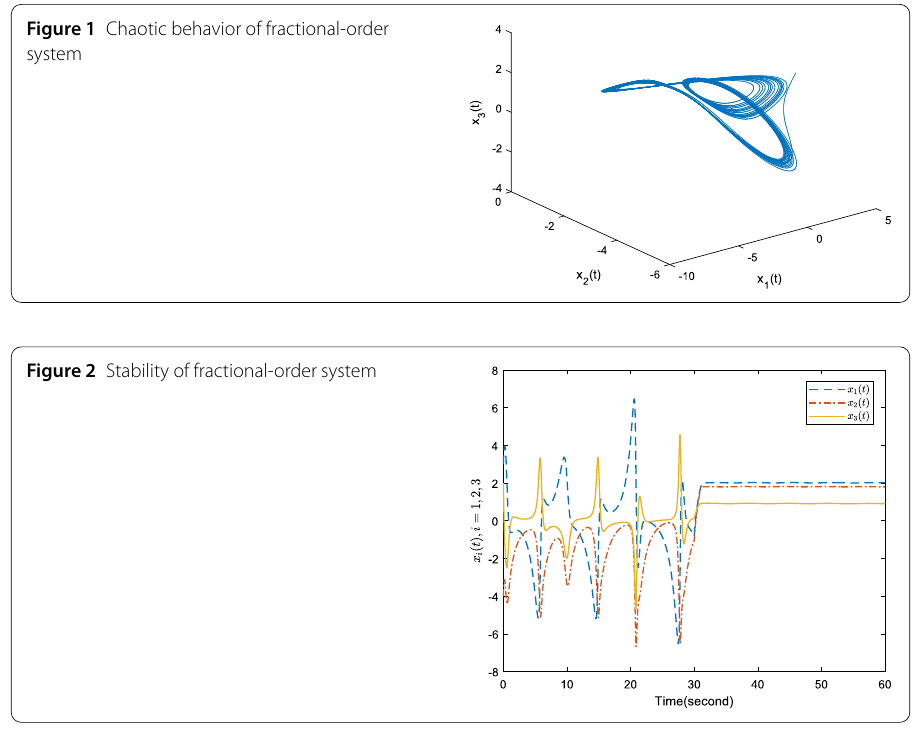
Figure 1 Chaotic behavior of fractional-order system